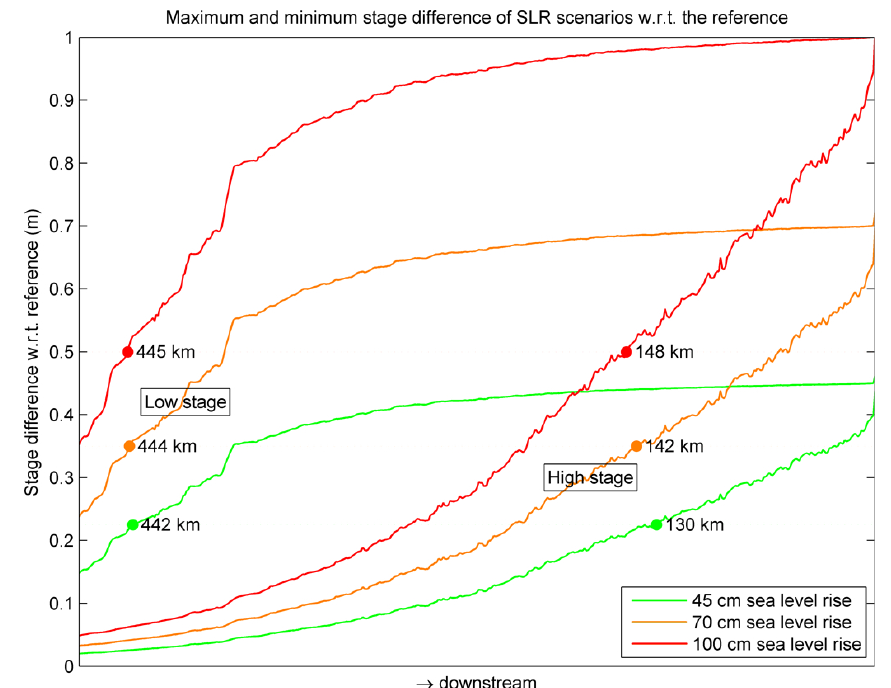
Figure 5. Minimum and maximum stage di ff erences with respect to the reference for three sea level rise